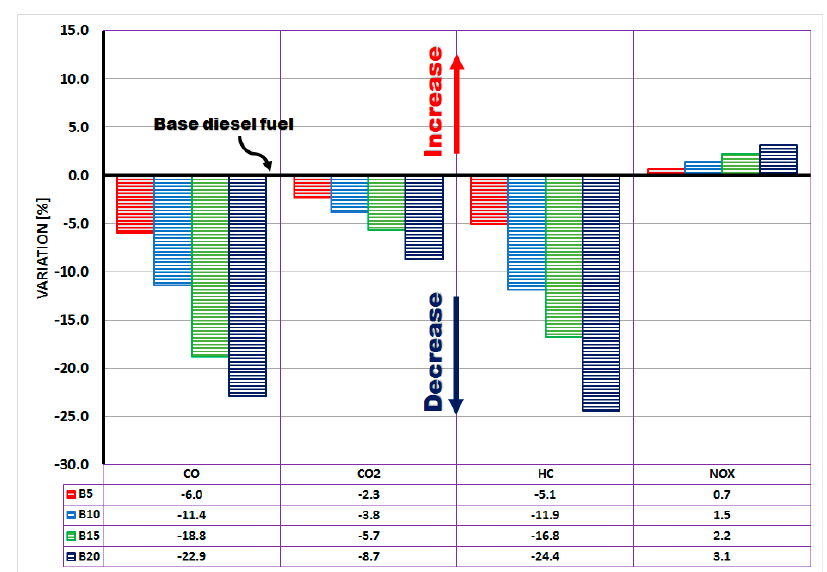
Figure 8. DSO biodiesel engine tailpipe emission performance metrics averaged over all speeds and loads and normalized against baseline petrol diesel.